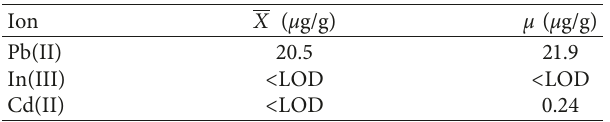
Table 2: Cd(II), Pb(II), and In(III) determination in CRM by the DP-ASV method (using the CPE modified with Bi 2 O 3 ) and μ value of CRM.